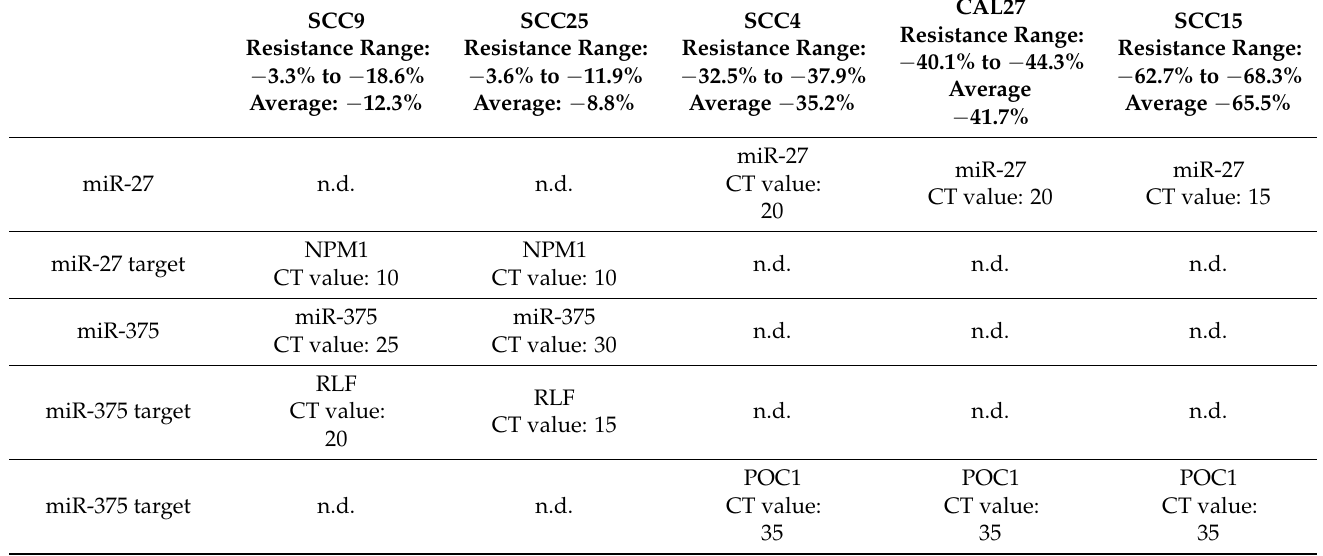
Table 3. Association between miRNA expression and potential downstream targets in oral cancer cell